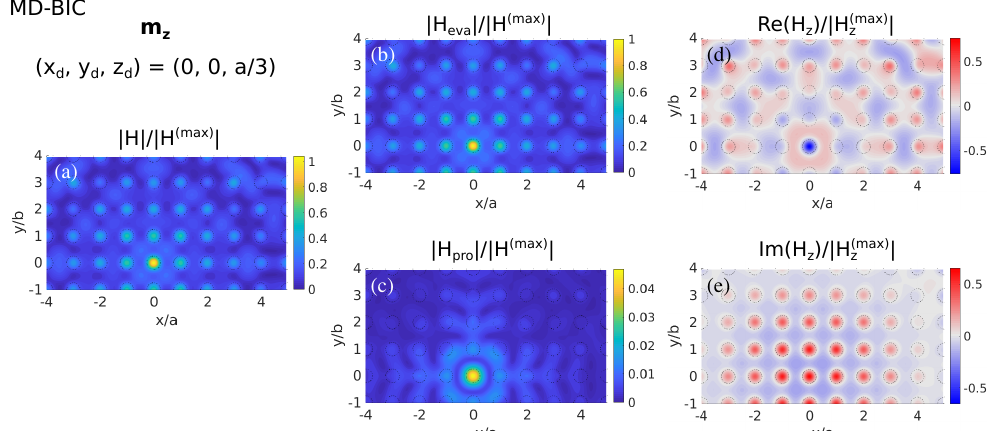
Figure 8. Color maps of near-fields as in Figure 4, but for the magnetic field at the wavelength of the symmetry-protected MD-BIC ( λ = 709 nm), illuminating with a vertical point MD source located at ( x d , y d , z d ) = ( 0,0, a /3 ) ; thus, z d = z ≈ 133 nm: ( a ) Total magnetic field amplitude, showing separately the contributions from the ( b ) evanescent and ( c ) propagating components, and the real ( d ) and imaginary ( e ) parts of the vertical electric field